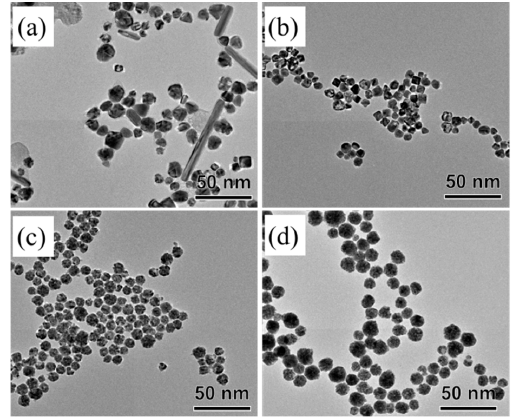
Figure 2. TEM images of as-prepared AgPd nanoparticles: ( a ) AgPd-1.3, ( b ) AgPd-1, ( c ) AgPd-0.8, and ( d ) AgPd-0.66.